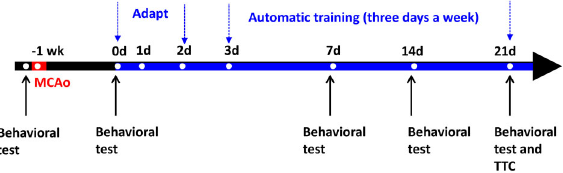
Figure 6. Experimental timeline for verifying the effectiveness of stroke rehabilitation. MCAo: middle cerebral artery occlusion; TTC: triphenyl tetrazolium chloride